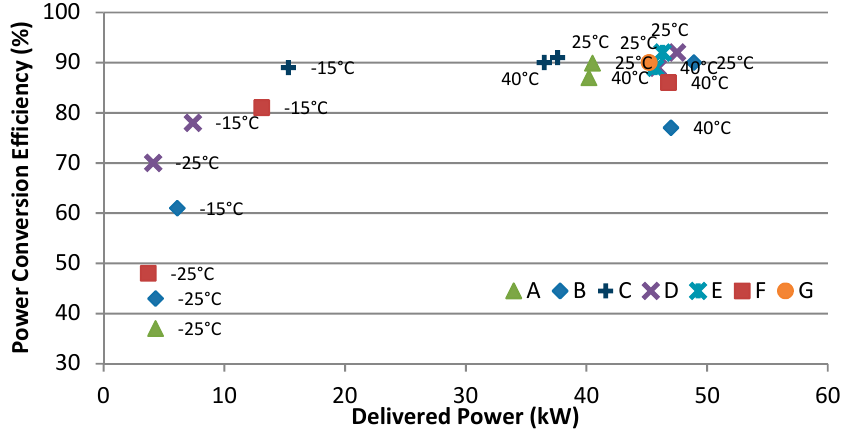
Figure 7. Power conversion efficiency as a function of the delivered power.